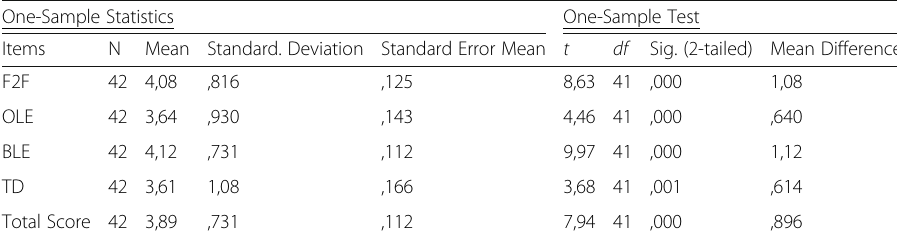
Table 3 One sample t -test One-Sample Statistics One-Sample Test